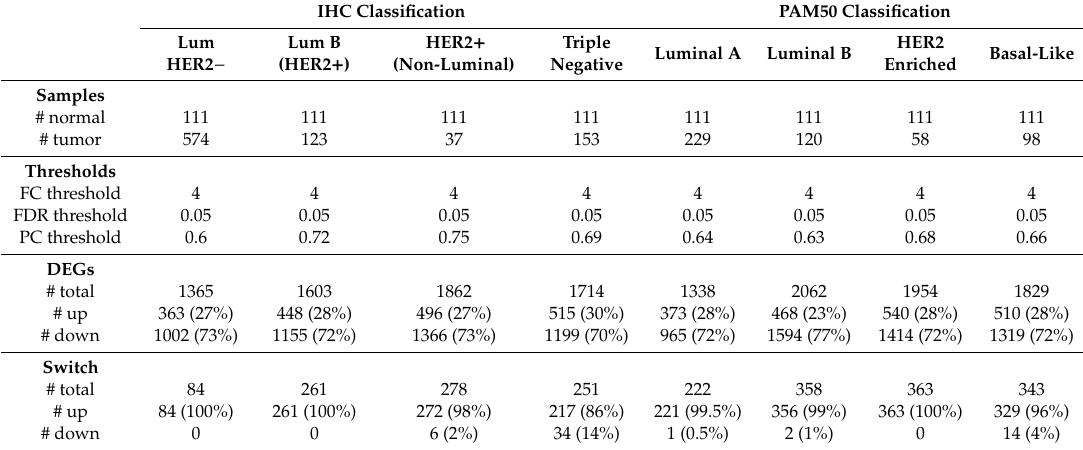
Figure 1. Bioinformatic workflow. Study design for the identification of breast cancer switch genes from IHC and PAM50 subtype classification. ( A ) Computational analysis; ( B ) Integrated functional analysis; ( C ) Integration of IHC and PAM50 Key Regulatory Switches. pos: positive; neg: negative. Table 1. This table reports the parameters and the results for each comparison subtype vs normal .